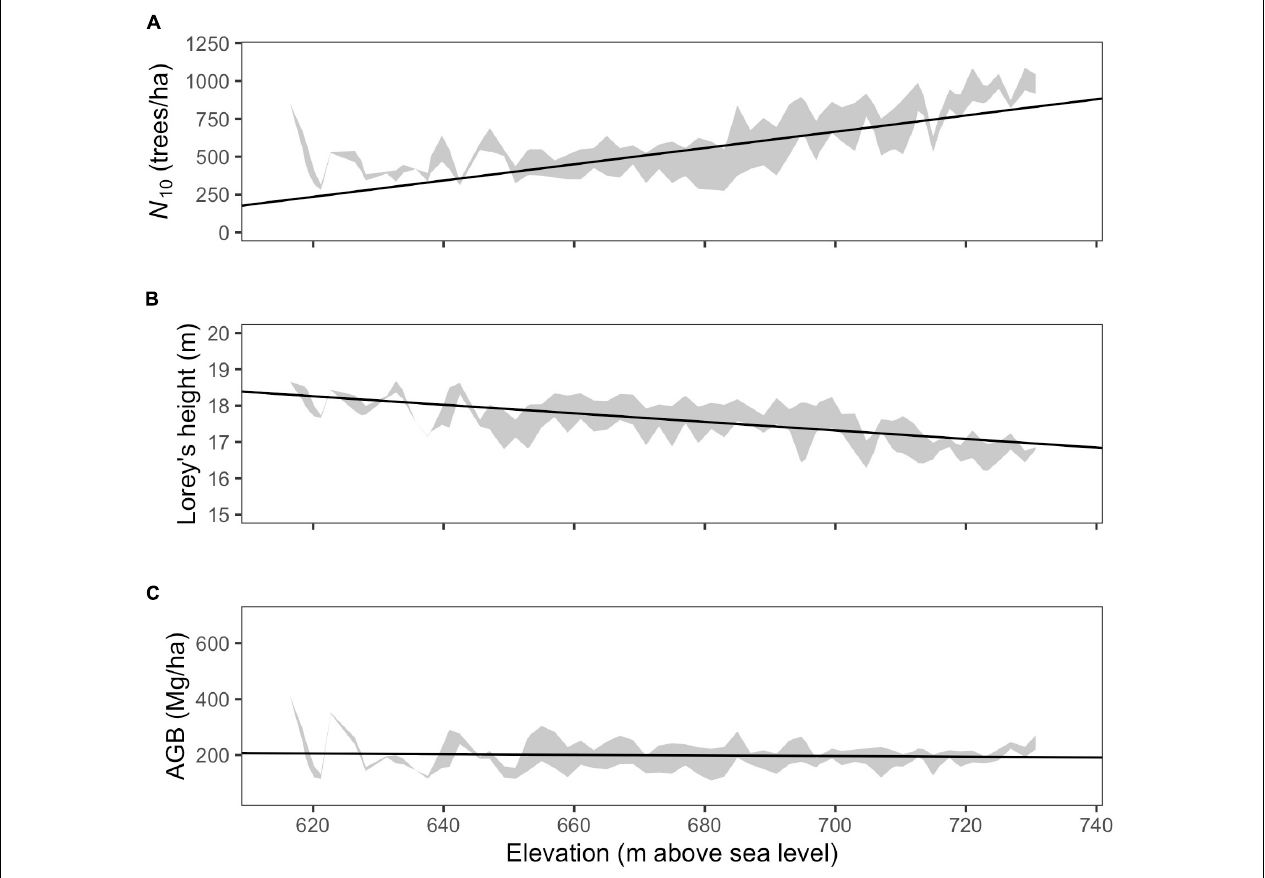
FIGURE 5 | Quadrat-wide (20 m × 20 m) forest summary statistics at the Fushan site, as a function of the quadrat elevation above sea level. Shaded areas represent interquartile ranges (IQR), calculated within a moving window frame (2 m) across the whole x -axis value range and then linearly interpolated to the x -axis value at each quadrat. Solid lines represent the linear regression curve. (A) N 10 , density of stems with DBH > 10 cm (trees ha − 1 ). (B) Lorey’s height, basal area-weighted mean tree height (m). (C) AGB, aboveground biomass (Mg ha − 1 ). The quadrat-wide values were converted to corresponding hectare-wide values.